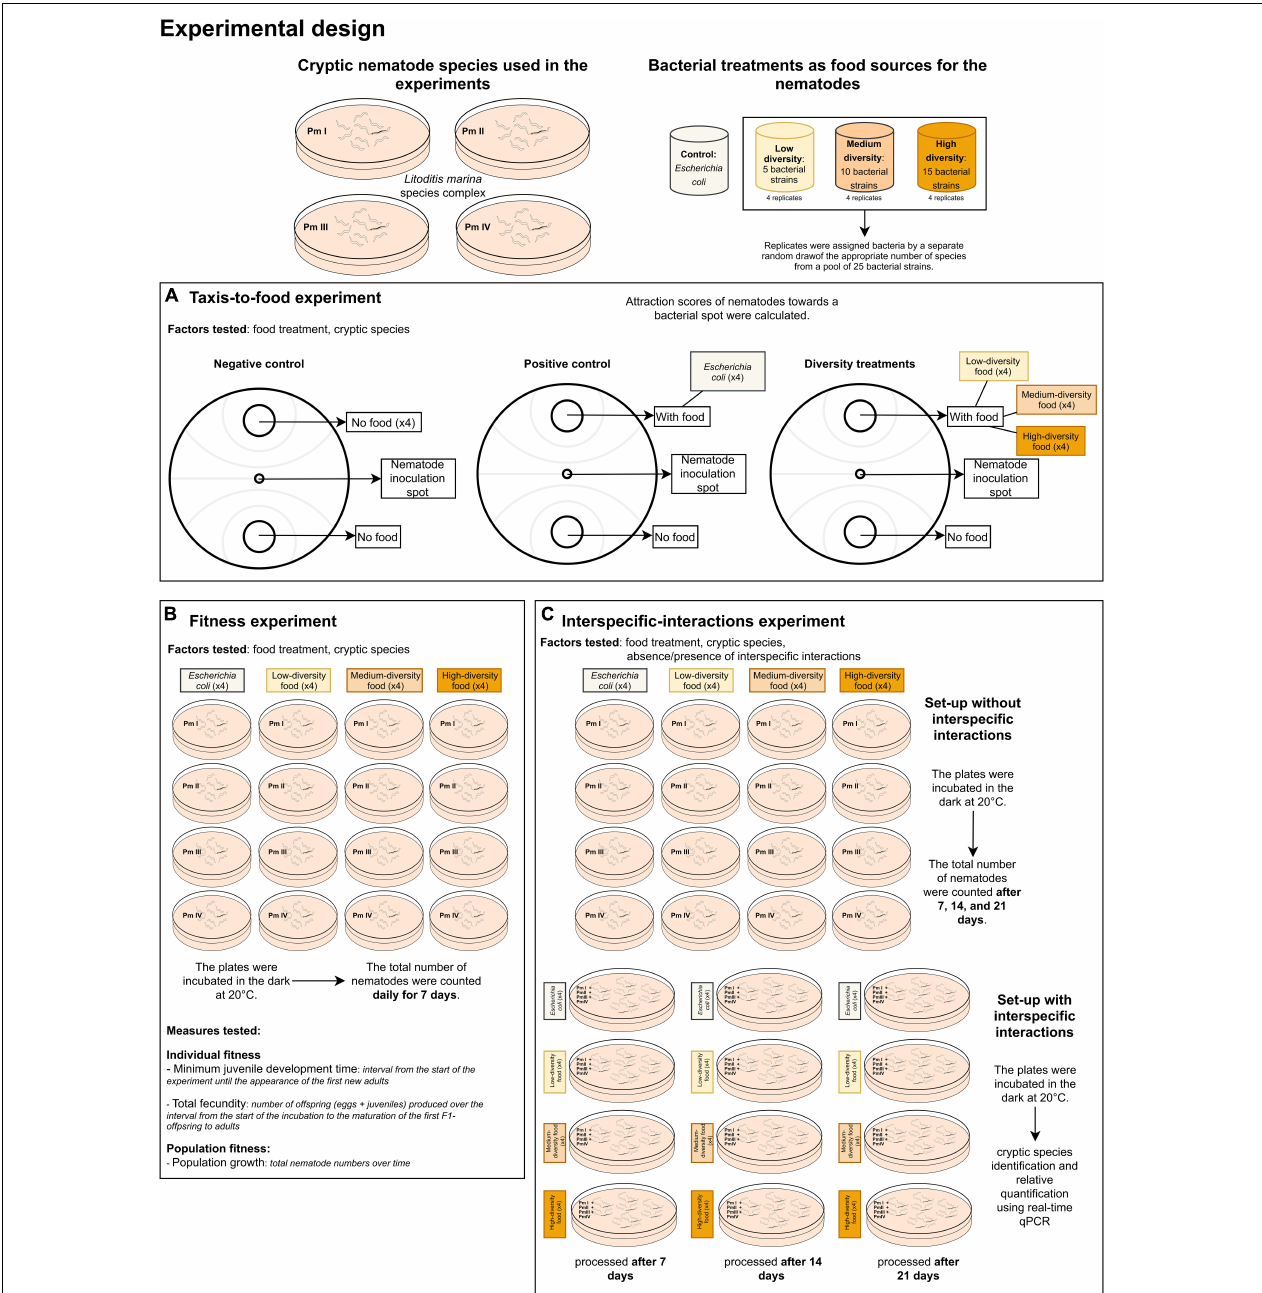
FIGURE 1 | Summary of the experimental design showing the (A) cryptic species of L. marina and the food (bacteria) treatments used in the experiments including the set-ups for the (B) taxis-to-food, (C) fitness, and (D) interspecific interactions experiments.